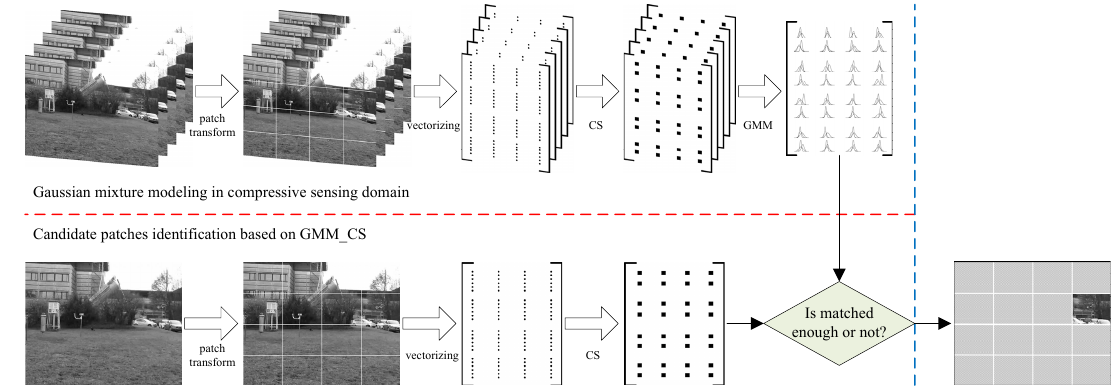
Figure 1. A demonstration of candidate patches identification based on